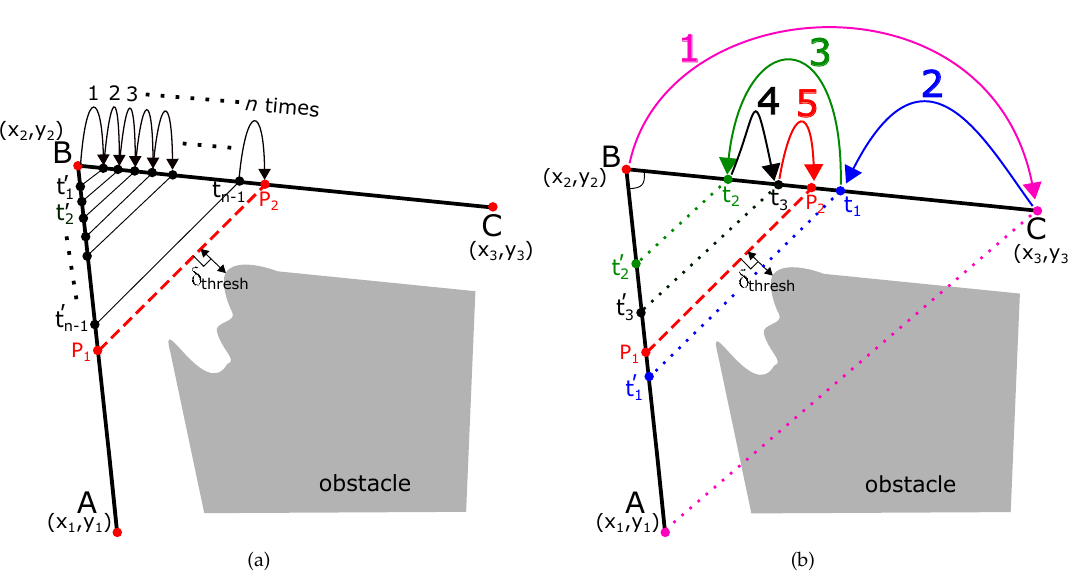
Figure 3. Normal and accelerated diffusion of point B. ( a ) normal diffusion; ( b ) accelerated diffusion based on binary search.